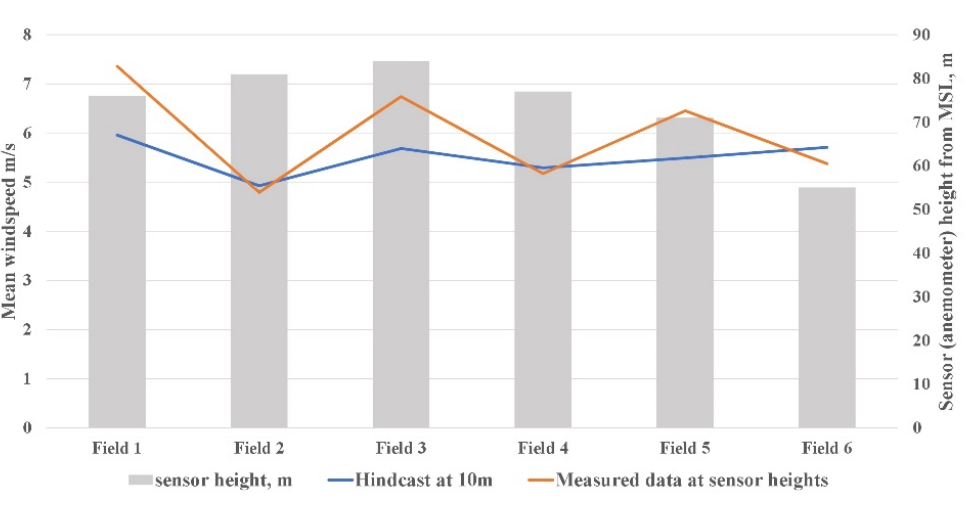
Figure 4. Comparison between hindcast and measured windspeeds.